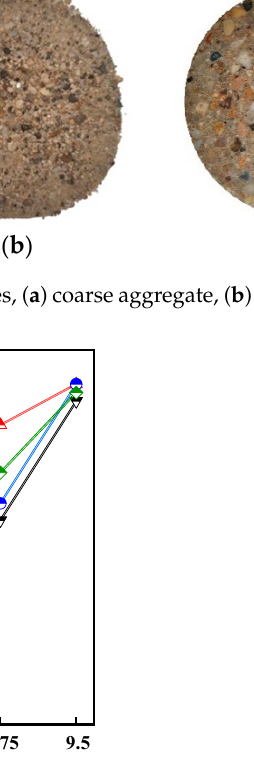
Figure 2. Gradation curves of mixtures. Table 1. Aggregate Grading.